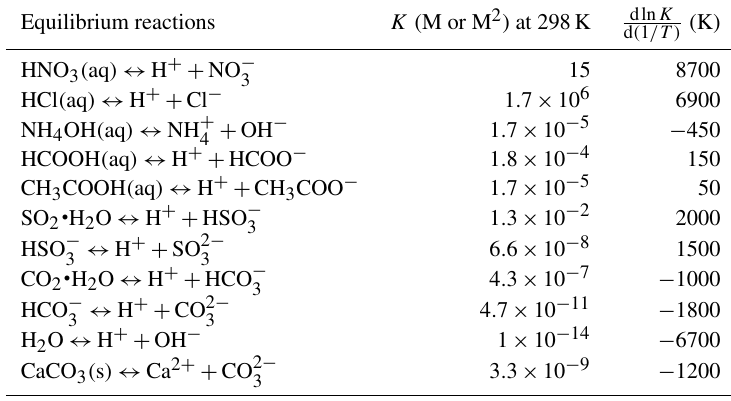
Table 2. Acid–base dissociation constants for the calculations of cloud water and precipitation pH ∗ . Equilibrium reactions